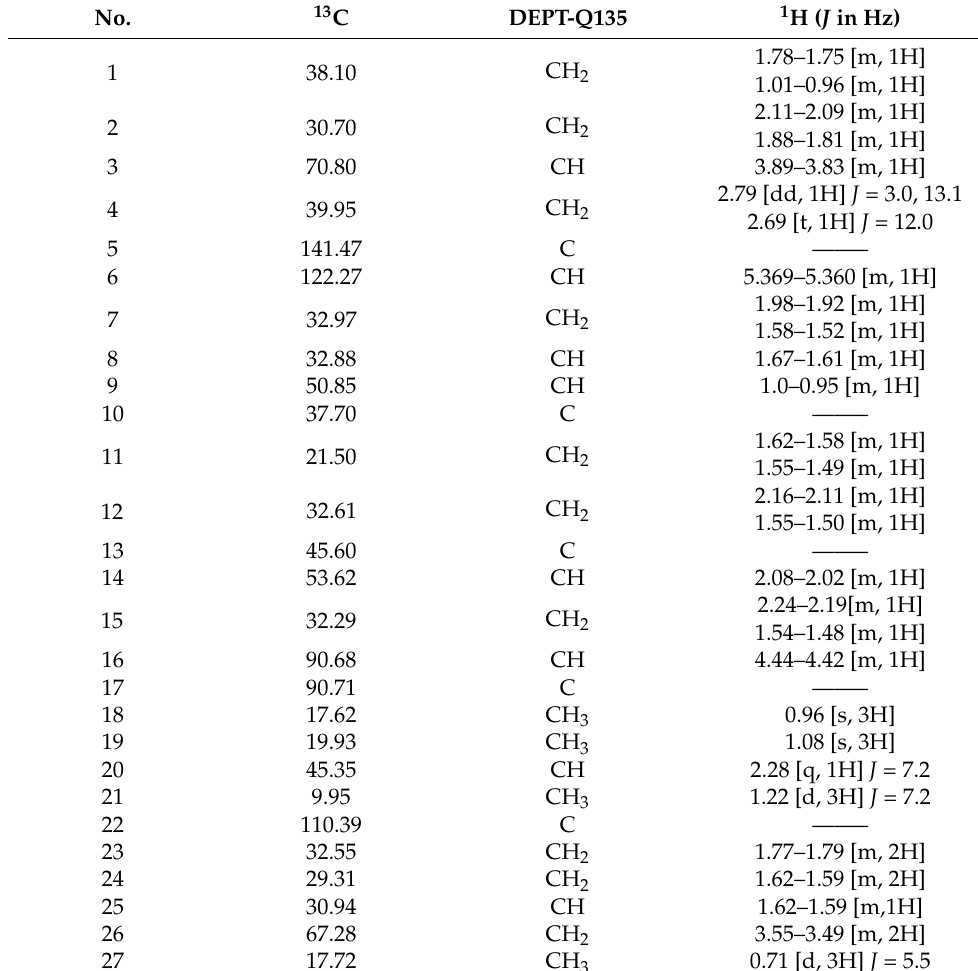
Table 2. Spectroscopic data of 1 H-NMR and 13 C-NMR spectra [500 and 125 MHz, Pyridine- d 5 , 50 ◦ C] of the aglycone part of pennogenin tetraglycoside.